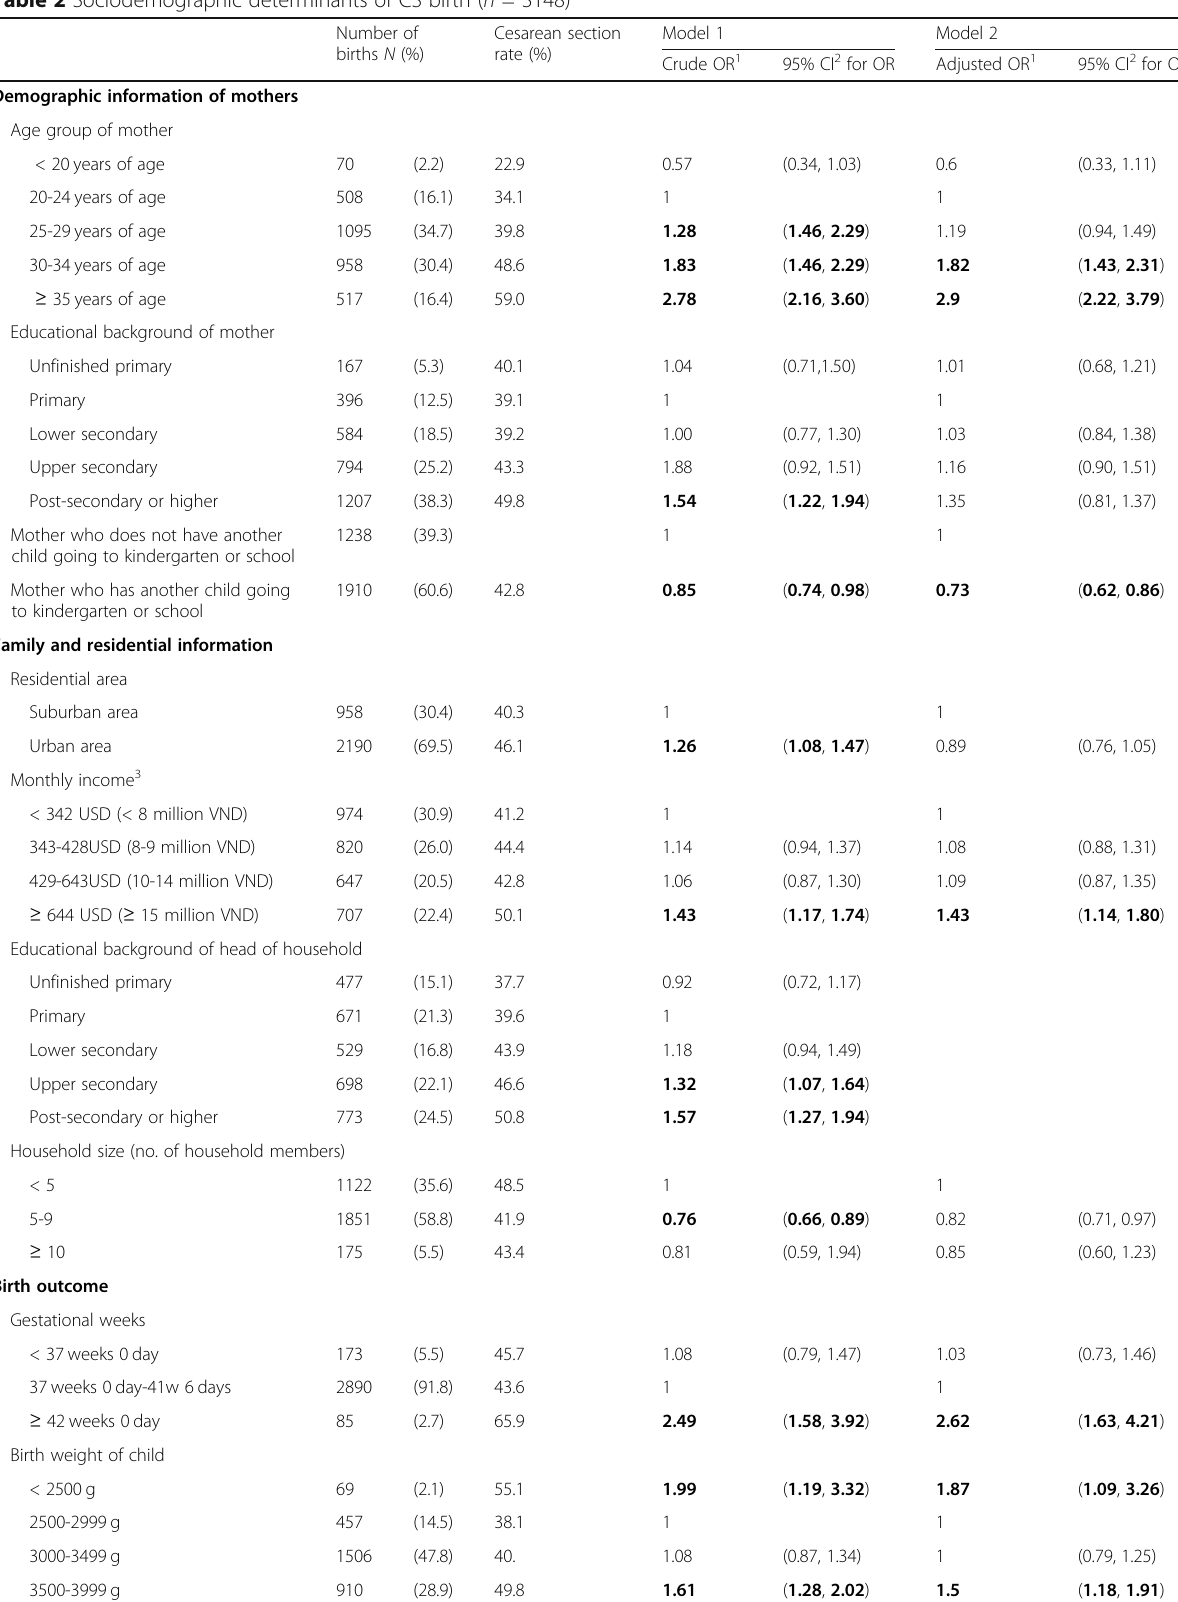
Table 2 Sociodemographic determinants of CS birth ( n = 3148)